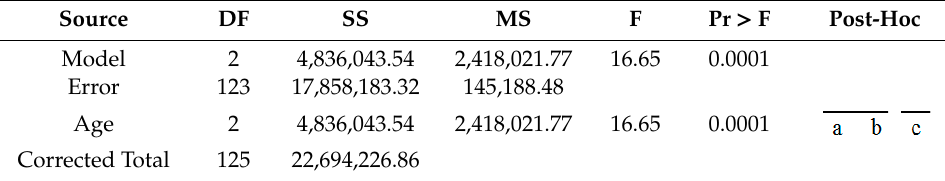
Table 6. Tukey post-hoc analysis in female participants according to age. Table 9. Tukey post-hoc in female participants according to age.